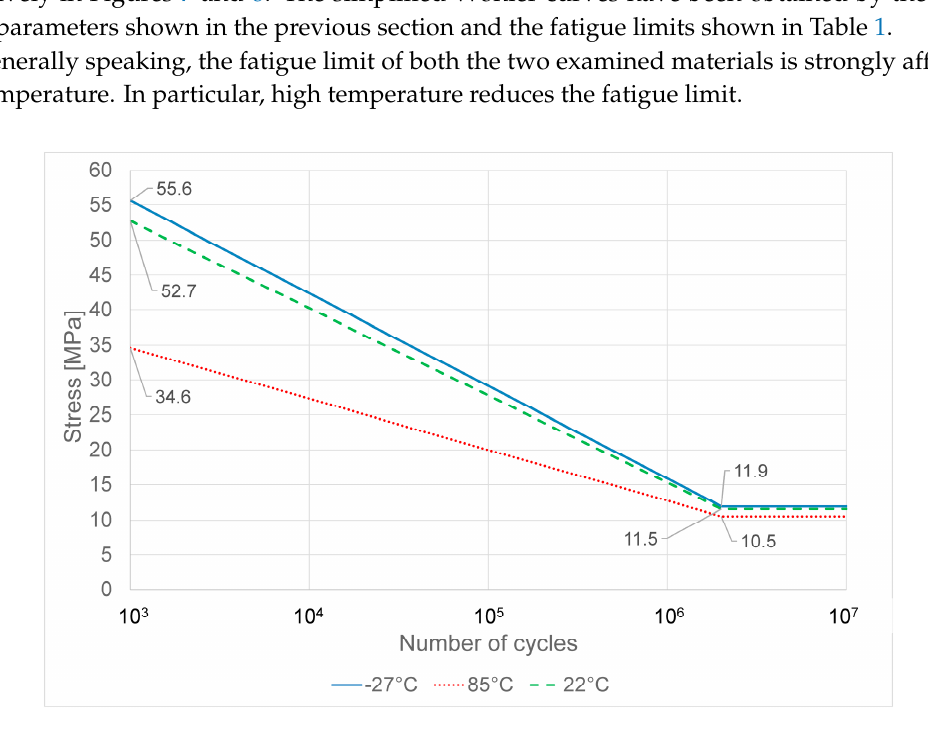
Figure 7. Wöhler curve at 50% survival for PC-ABS at different temperatures.